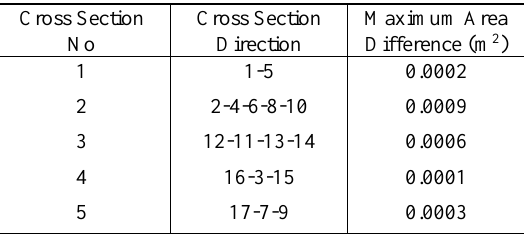
Table 4. Comparison of the cross